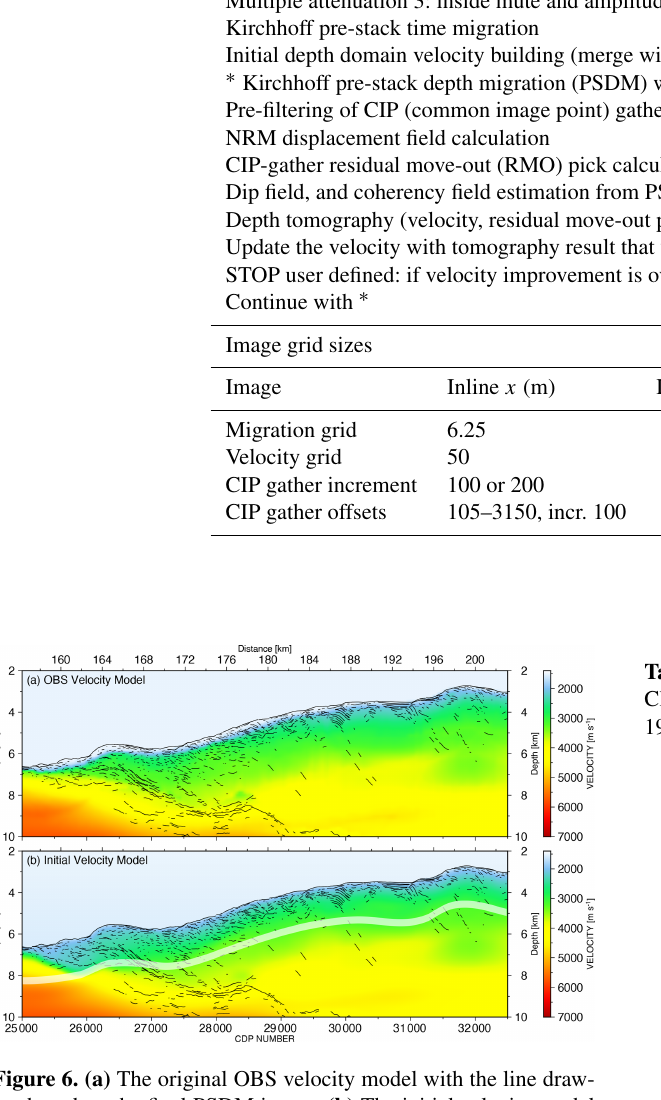
Figure 6. (a) The original OBS velocity model with the line draw- ing based on the final PSDM image. (b) The initial velocity model for the reflection tomography merged from the multi-channel seis- mic velocity analysis above the white transparent band and the wide-angle velocity model (below the white transparent band). The line drawing is based on the final PSDM image.